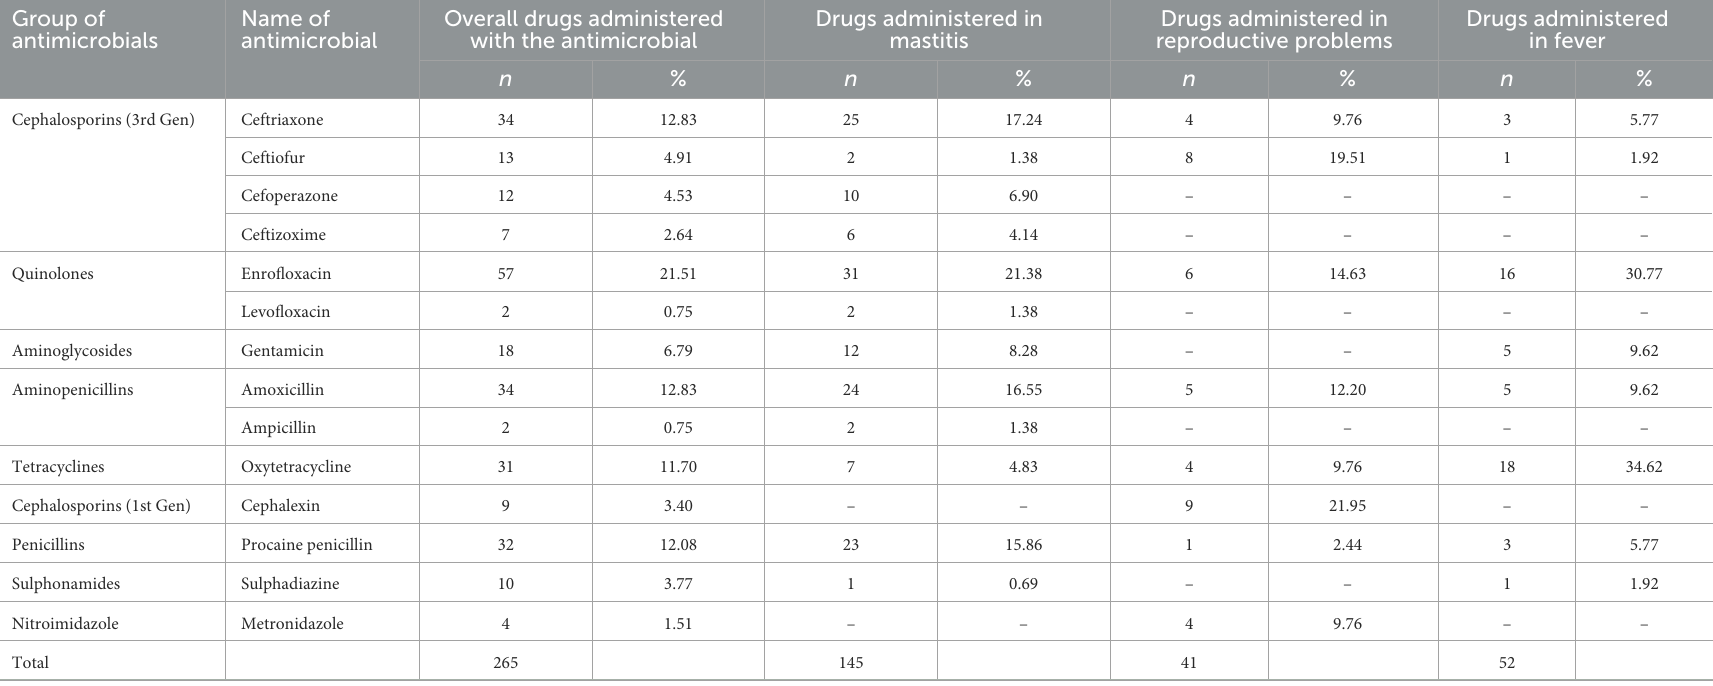
TABLE 1 Frequency of antimicrobial agents administered in the dairy herds (overall and condition wise). Group of antimicrobials